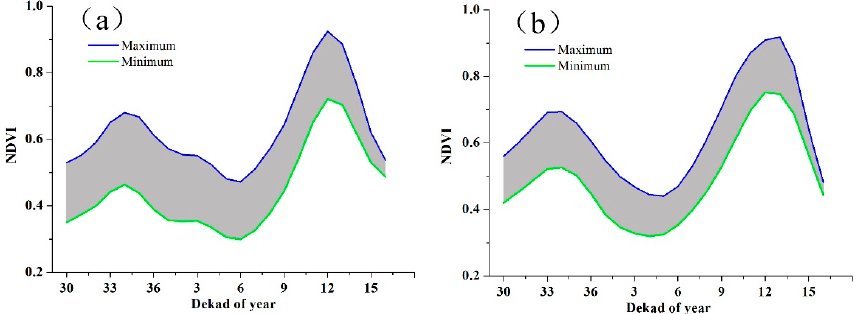
Figure 3. Time-series Normalized Difference Vegetation Index (NDVI) profiles plotted according to the field surveys: ( a ) Time-series NDVI profile of winter wheat at Site 1; and ( b ) Time-series NDVI profile of winter wheat at Site 2.